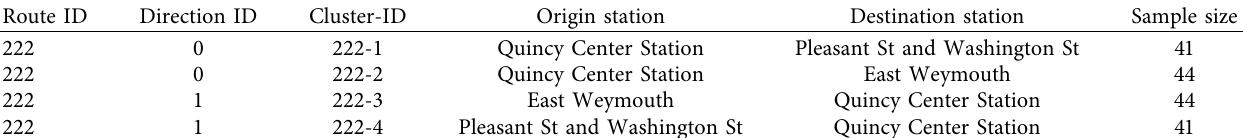
Table 1: Sample of trip clustering in the case study of MBTA.